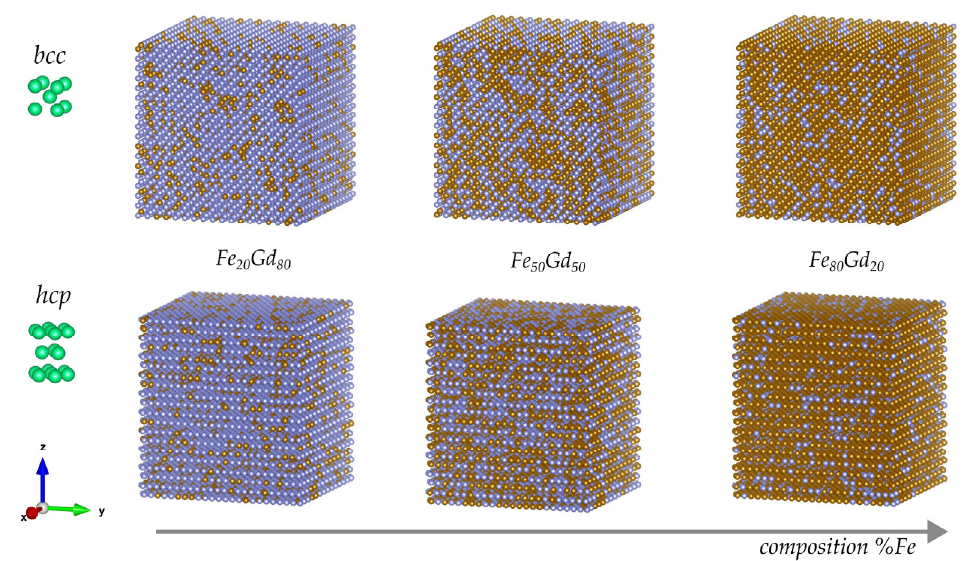
Figure 1. Graphical visualization of the simulated structures of FeGd alloys with different compositions and crystal structures used as the basis of random alloy generation (three exemplary concentrations of Fe atoms in alloys are shown). Blue balls correspond to gadolinium used atoms and orange to iron atoms, whereas the green balls shown are the crystal structures.